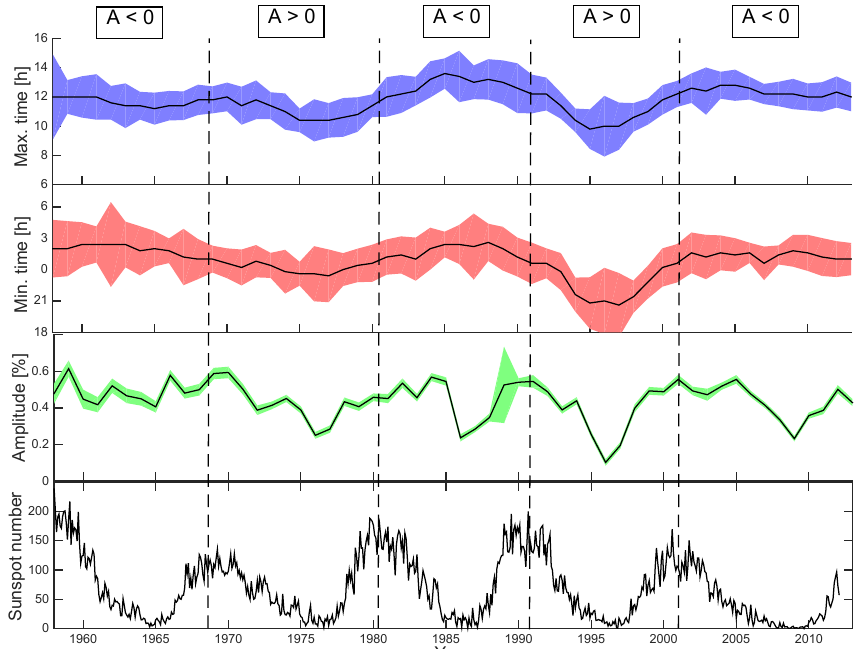
Figure 8. Neutron monitor data from Hermanus, South Africa (34.4 ◦ S, 19.2 ◦ E). Mean times of day of (from top) the maximum in the diurnal variation of neutron monitor counts, the minimum, the mean amplitudes of the variation and the international sunspot number. Shaded regions are the error calculated for individual years as the times. The computation of uncertainties is described in the text. The vertical dashed lines are times of polarity reversal estimate by Thomas et al. (2014a) and the solar magnetic polarity of each cycle is labelled at the top.